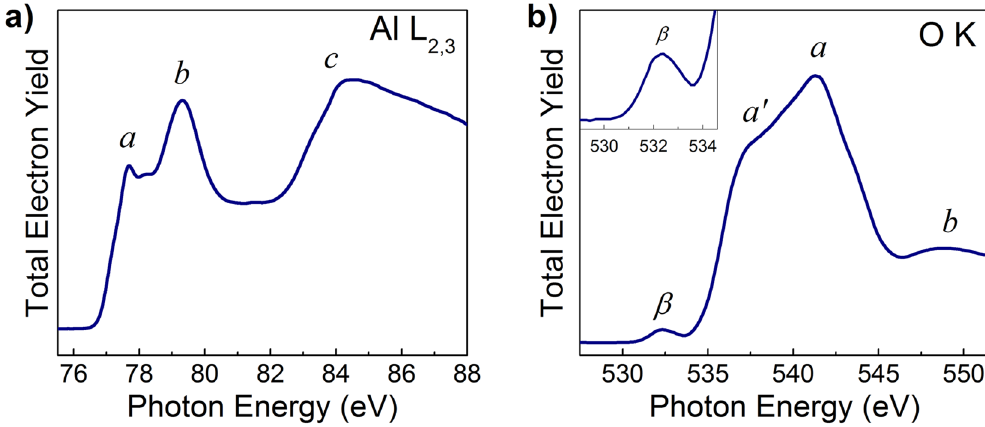
Figure 5. ( a ) Al L 2,3 - and ( b ) O K-absorption spectra of the γ -Al 2 O 3 films measured outside the TiN electrode (after contact with electrode–see Methods section, end of the first paragraph) by monitoring the total electron yield when the drain current from the sample is